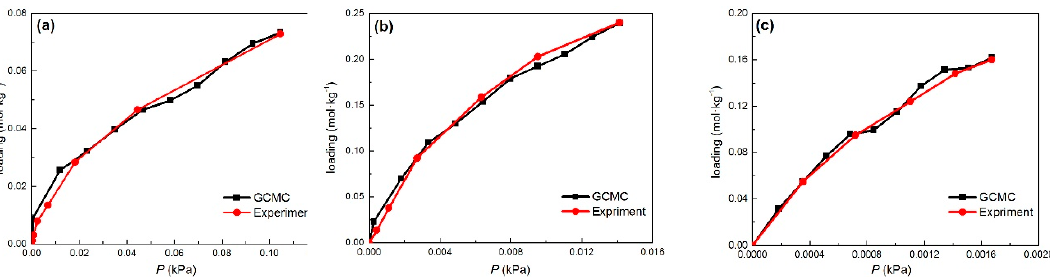
Figure 1. Adsorption isotherms for Nap, Phe, and Pyr on the MCM-41 model compared with experiment results at 398K. ( a ) Nap; ( b ) Phe; ( c ) Pyr; Key: red, grand canonical Monte Carlo (GCMC); black, experiment.